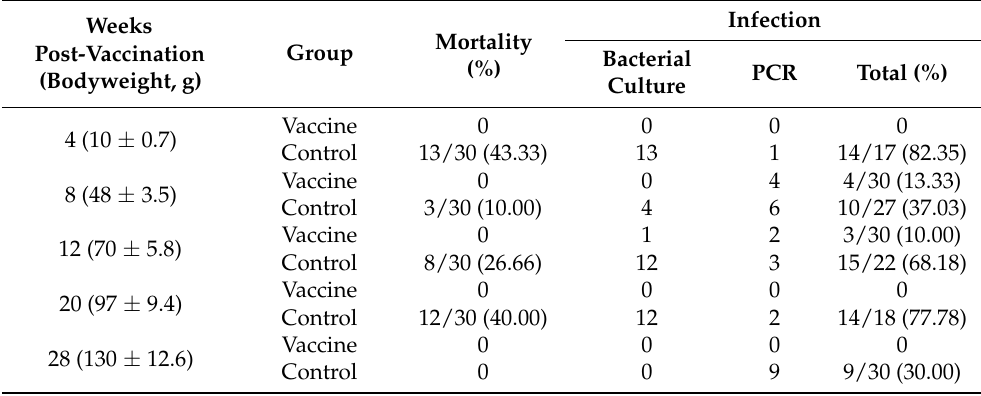
Figure 1. Juvenile Asian seabass intraperitoneally infected with S. iniae 10 10 CFU mL − 1 showing bilateral lens opacity and scale loss ( Left ). The whitish feces from the sick fish were observed in the experimental aquaria ( Right ). Table 2. Mortality rate and infection of the vaccinated and control fish following a challenge at 4, 8, 12, 20, and 28 weeks